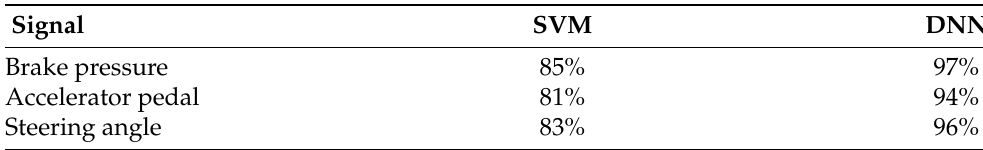
Table 8. Sensor isolation accuracy for SVM and DNN.